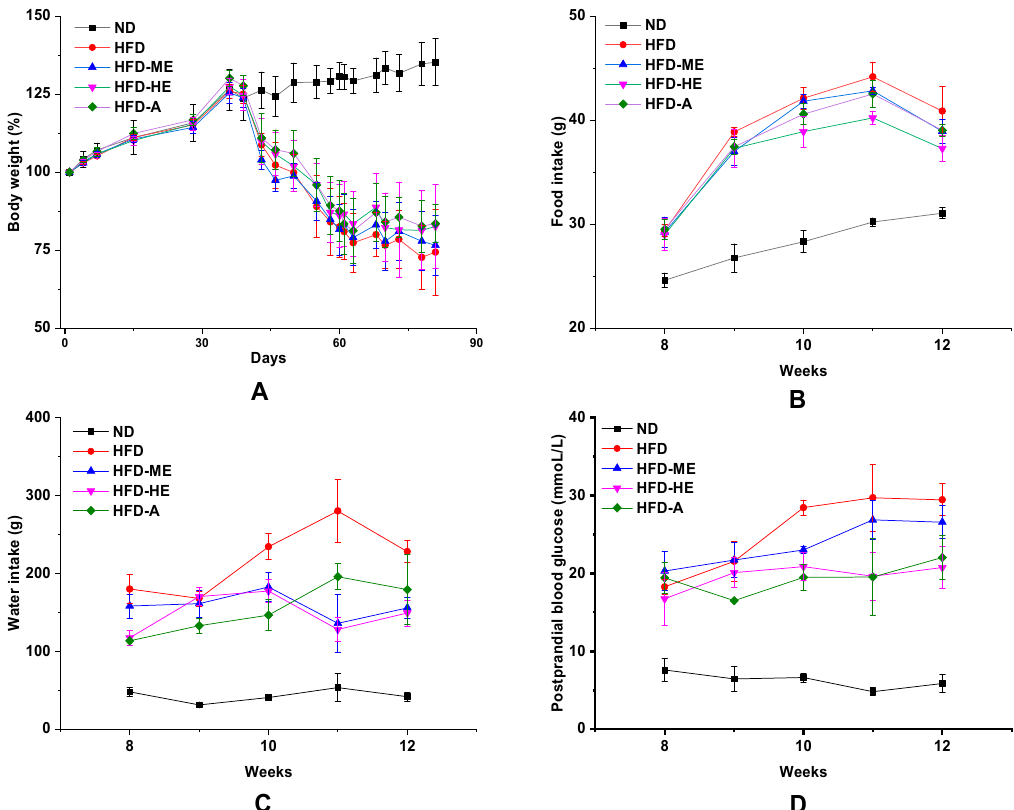
Figure 6. Effect of the ethyl acetate fraction of P. frutescens leaves on the biochemical parameters of STZ-induced diabetic rats. ( A ) Body weight; ( B ) food intake; ( C ) water intake; ( D ) postprandial blood glucose. ND = normal diet group; HFD = high-fat diet group; HFD-ME = high-fat diet with medium dose extracts group; HFD-HE = high-fat diet with high dose extracts group; HFD-A = high-fat diet with acarbose group.